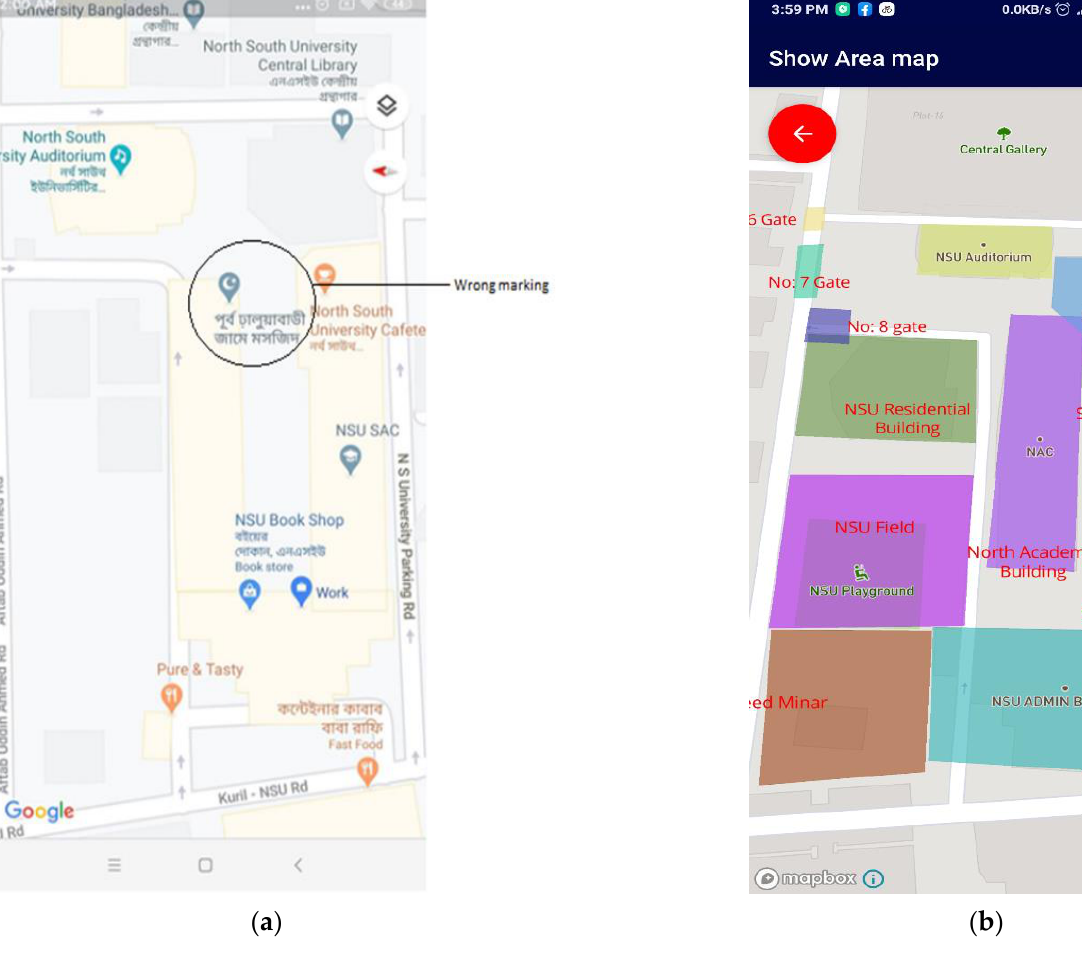
Figure 15. Top view from Google Maps ( a ) and the top view from the proposed application ( b ).